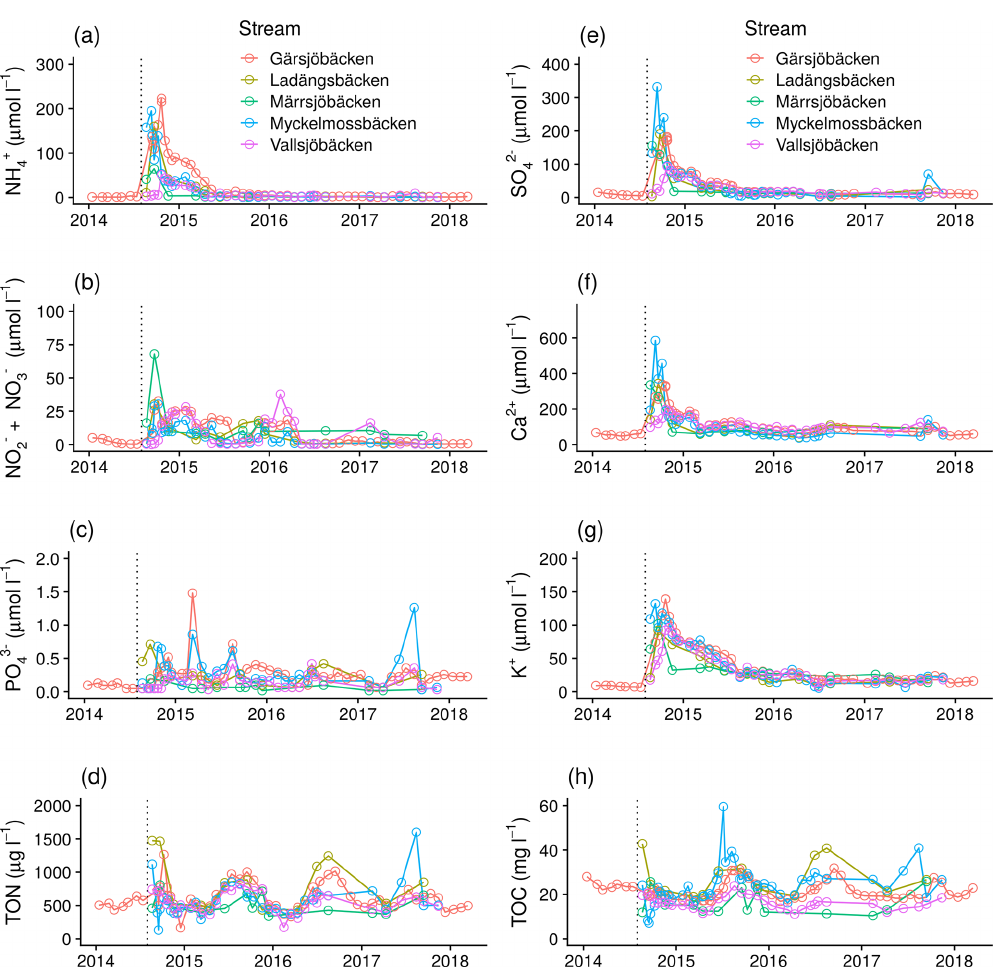
Figure 3. Temporal changes in concentration of nutrients and major elements in five catchments: (a) NH + (d) total organic N, (e) SO 2 −